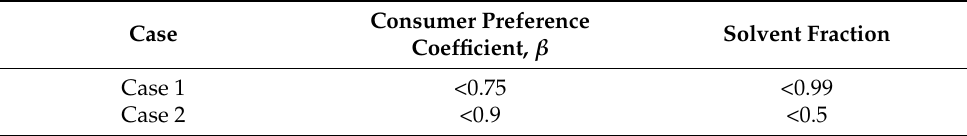
Table 5. Comparison of constraints for case study 1 and